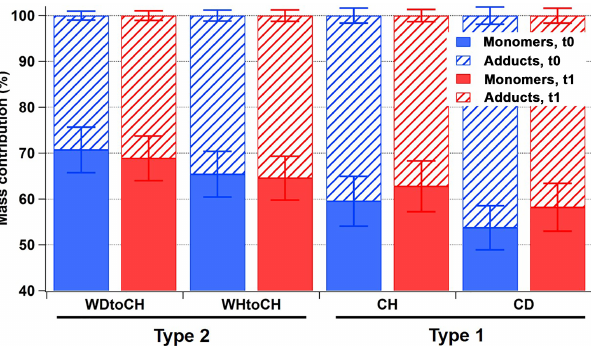
Figure 4. Relative mass contributions of monomers and adducts with error bars at t 0 (blue) and t 1